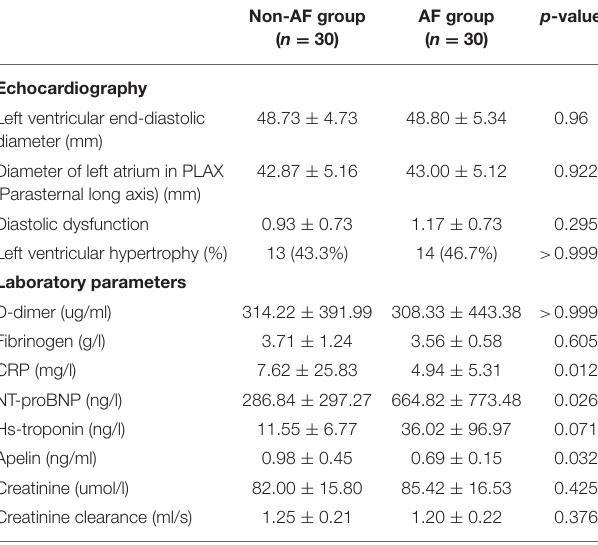
TABLE 2A | Patient characteristics: echocardiography and laboratory parameters.